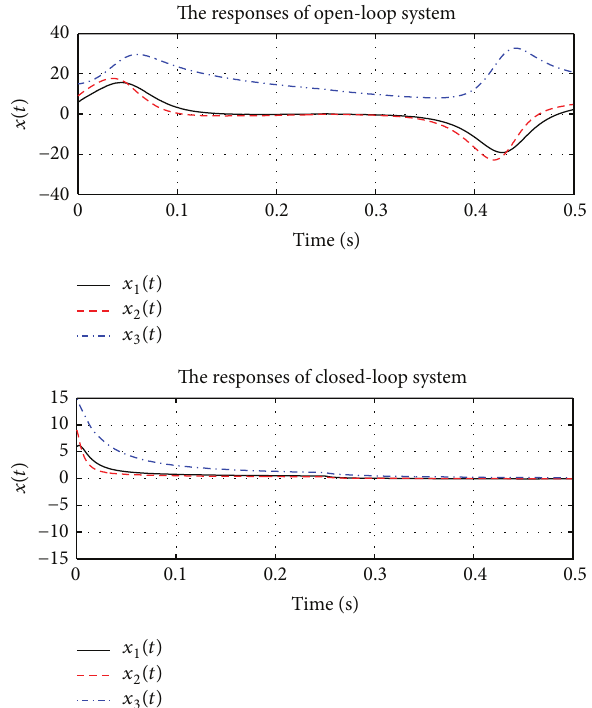
Figure 8: Results of Example 4 with control or